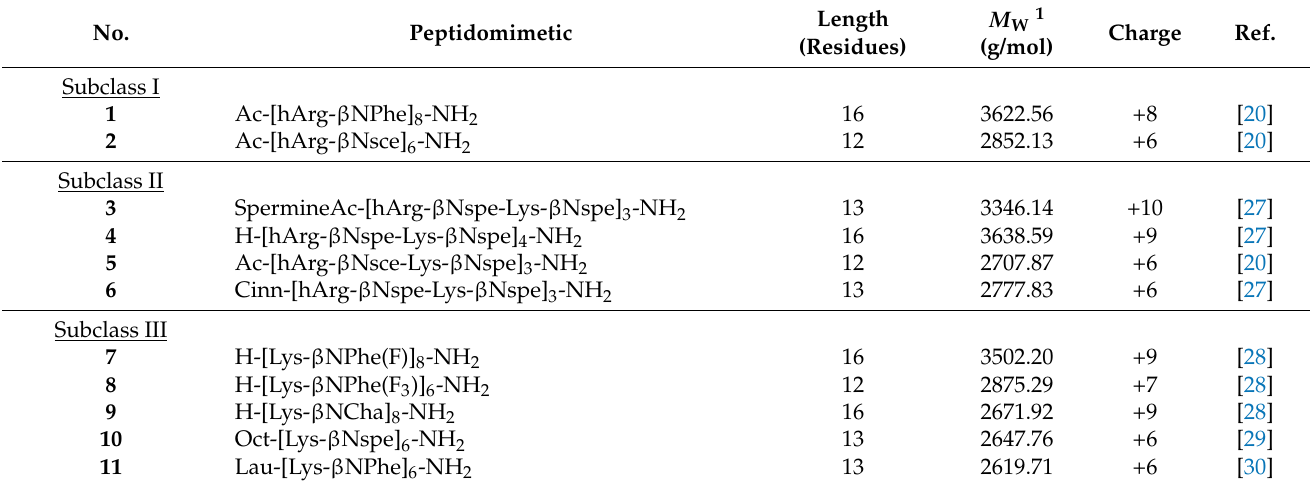
Table 1. Properties of peptidomimetics (oligomer length, molecular weight and net charge).